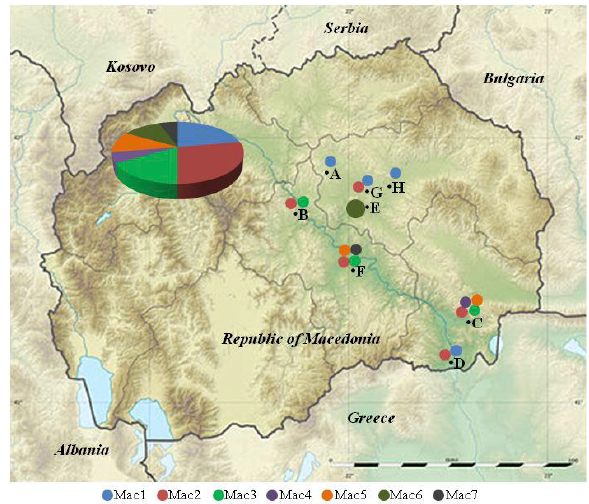
Figure 4. Distribution of bois noir (BN) phytoplasma geno- types in the Republic of Macedonia. Vineyard localities are represented as capital letters: A (Sveti Nikole), B (Veles), C (Valandovo), D (Gevgelija), E (Amzibegov Pesirovo), F (Kavadarci), G (Sarcievo), H (Argulica). BN phytoplasma genotypes (Mac1 to 7) are reported at marked localities as shown in the legend. Spot diameter is related to the number of BN phytoplasma strains. Pie graphic shows the prevalence of BN phytoplasma